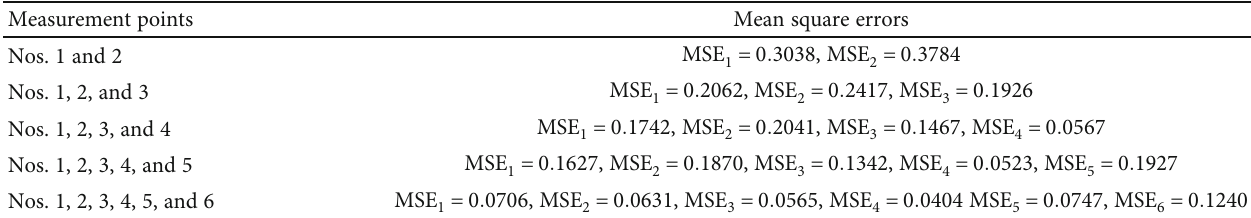
Table 2: Mean square errors with increasing number of measurement